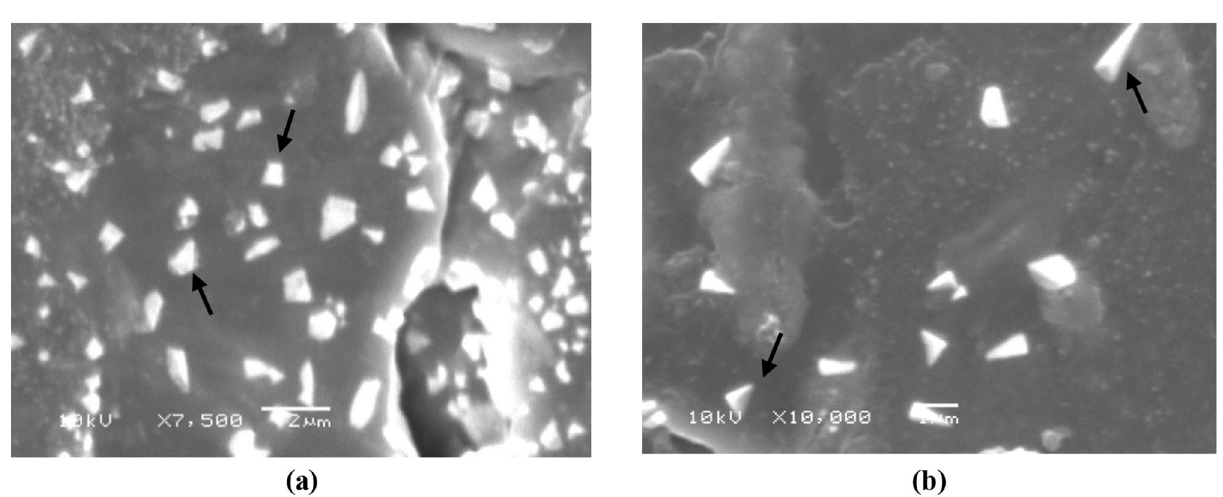
Figure 17. SEM micrographs showing morphology of biosynthesized iron nano particles before ( a ) and after ( b ) optimization